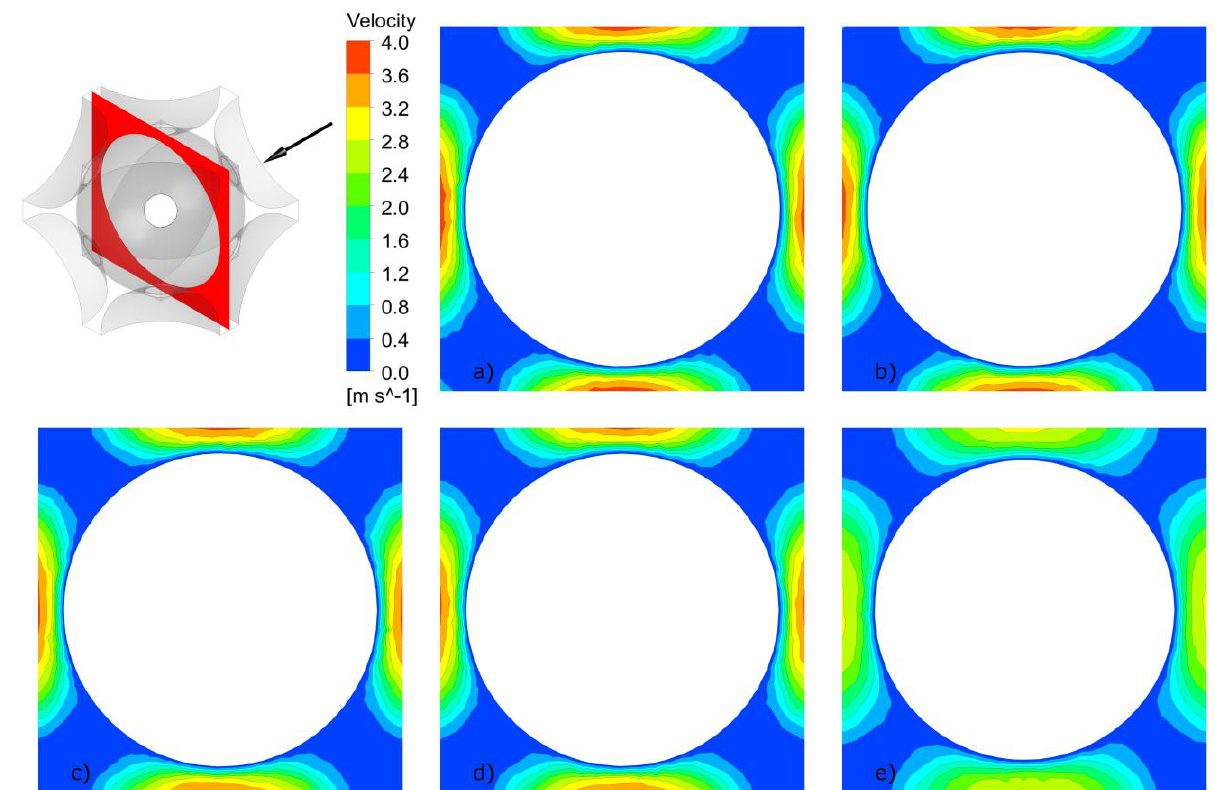
Fig. 10. Velocity magnitude on XY plane obtained with the discretization method of granule radius reduction R g% equal: a - 99.75%. b - 99.50%. c - 99.25%. d - 99.00%. e - 95.00%.